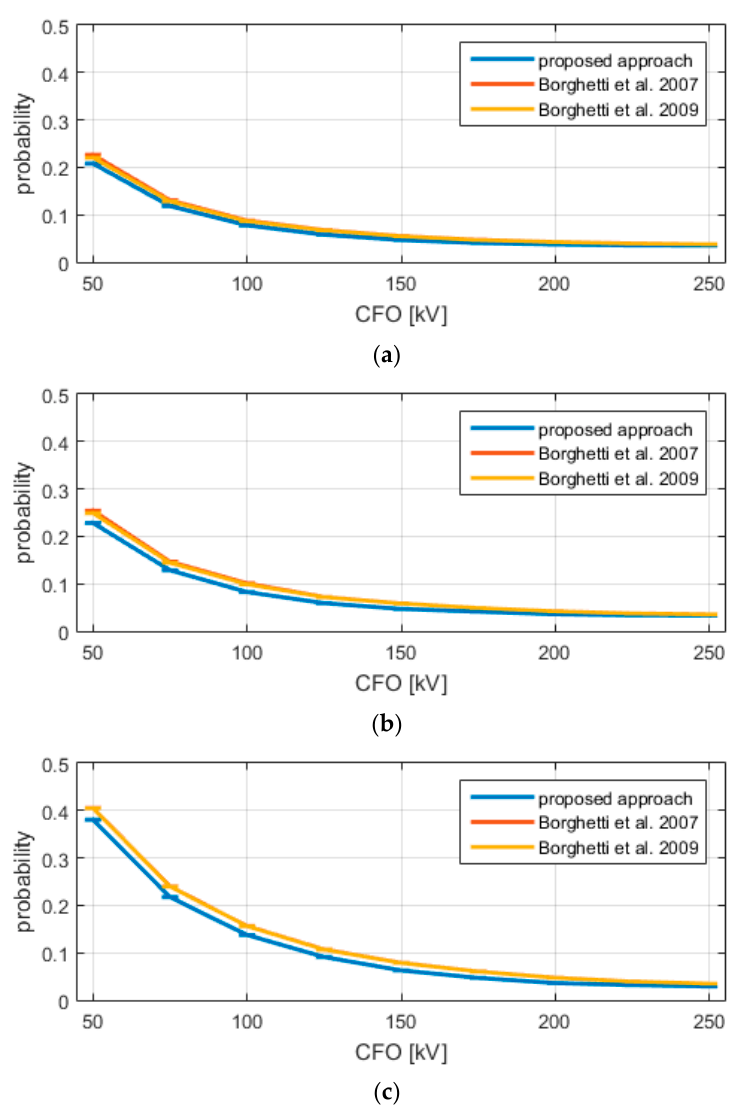
Figure 4. Comparison of the proposed approach with the ones in [3,4] in the evaluation of the lightning performance of a complex distribution network. Panels ( a – c ) show the results for Test1, Test2, and Test3, respectively.